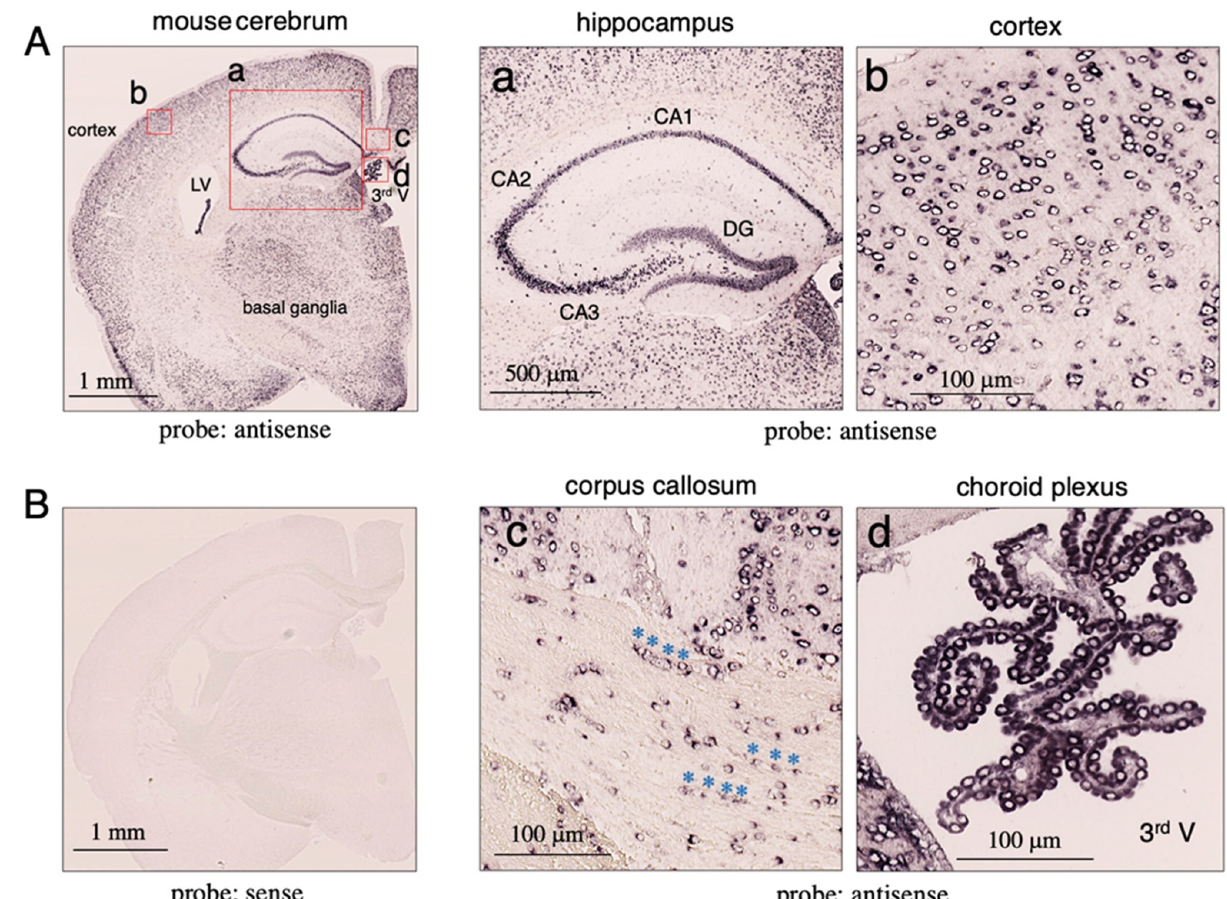
Figure 1. Expression of Tf mRNA in mouse brain tissue. Mouse brain sections (5 μ m thick) were subjected to in situ hybridization using DIG ‐ labeled antisense ( A ) or sense probes ( B ). The probe was detected with alkaline phosphatase ‐ conjugated anti ‐ DIG antibody. High magnification images of the hippocampus ( a ), cortex ( b ), corpus callosum ( c ), and choroid plexus ( d ) are shown. In the corpus callosum, Tf mRNA ‐ positive cells are indicated with blue asterisks ( c ). The lateral (LV) and third ventricles (3rd V) are indicated ( A ).